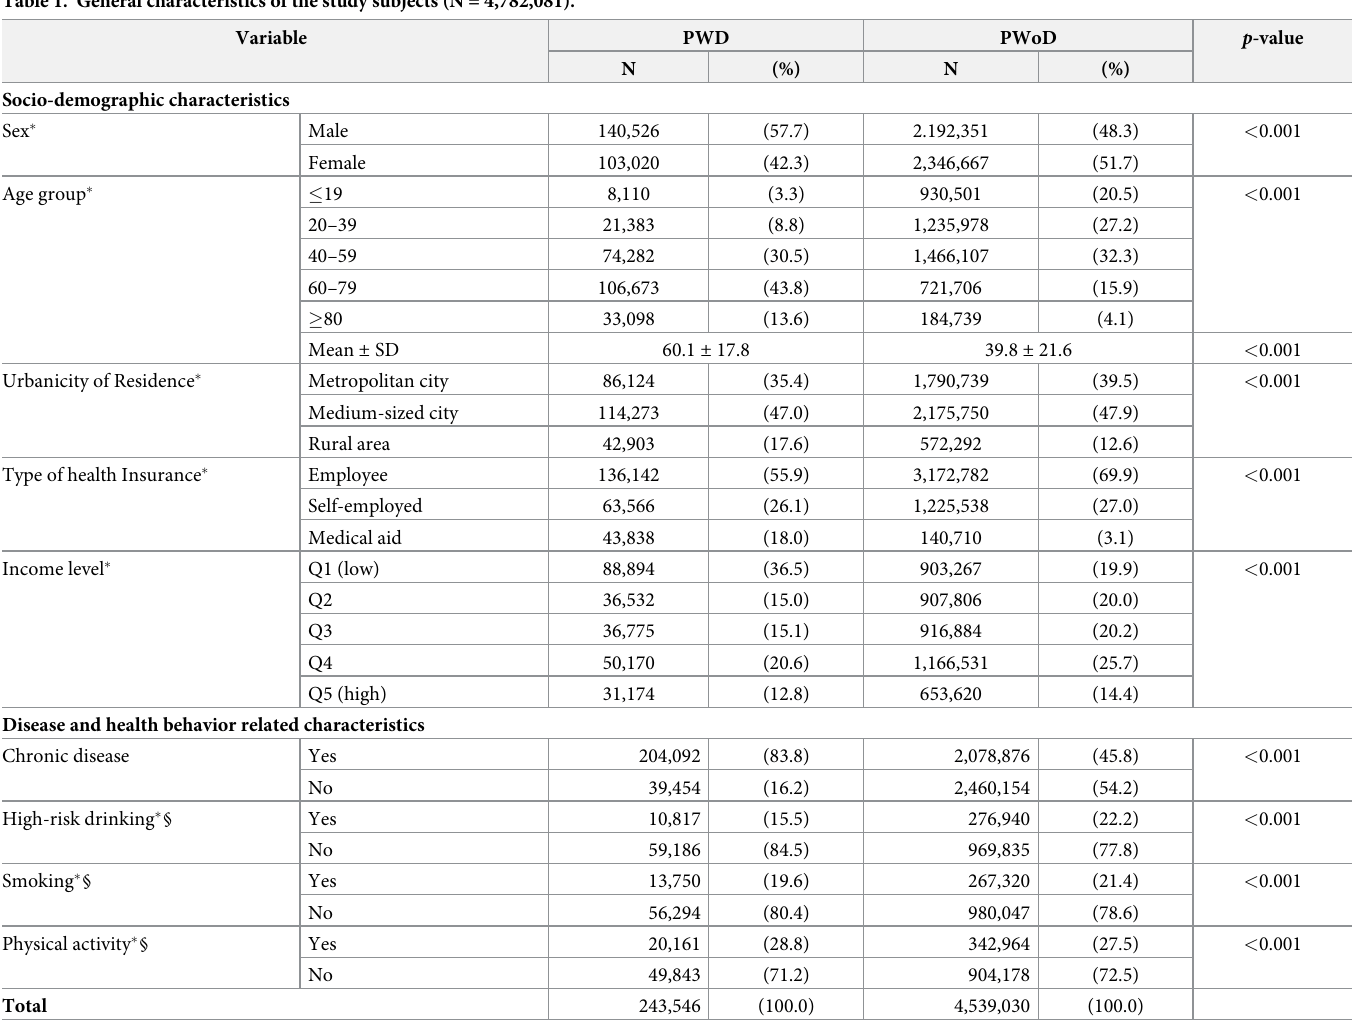
Table 1. General characteristics of the study subjects (N =